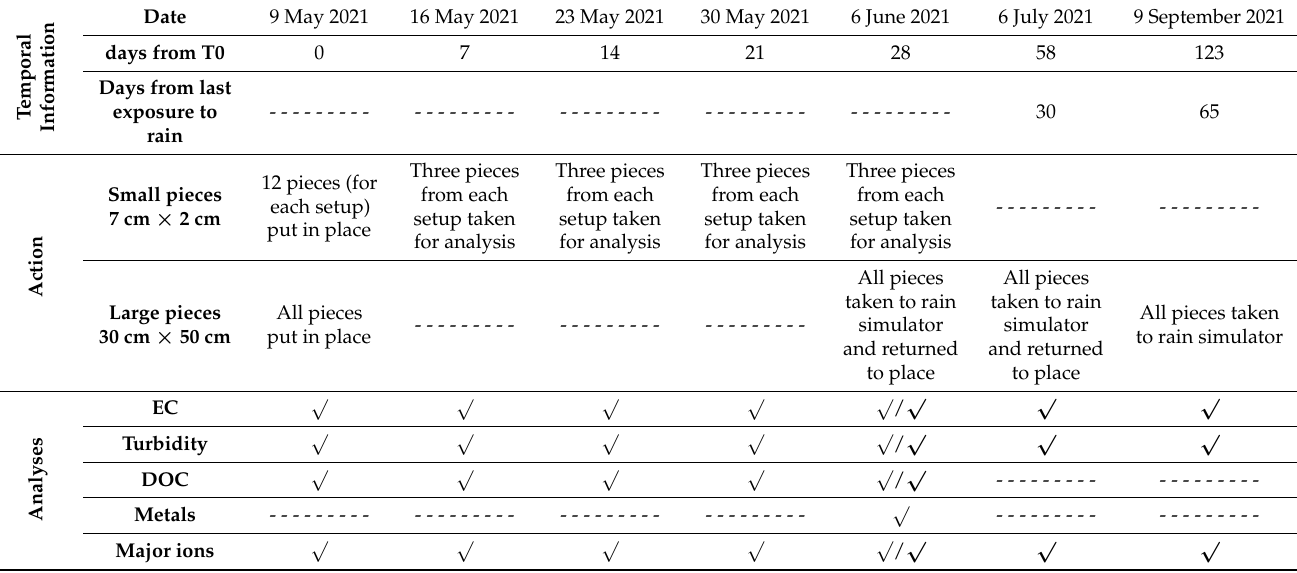
Table 3. Time scheme of the BS experiments. Non-bold and bold checkmarks ( large BS pieces,